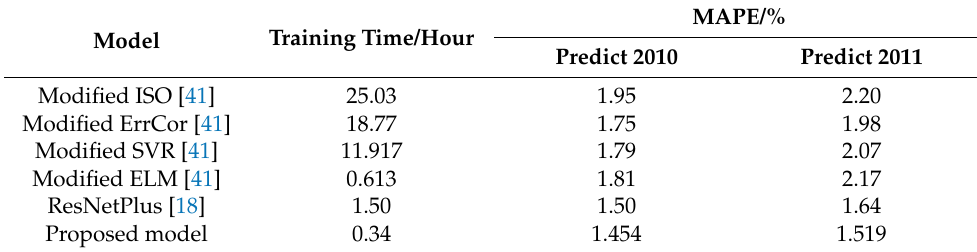
Table 7. Training time of various models.